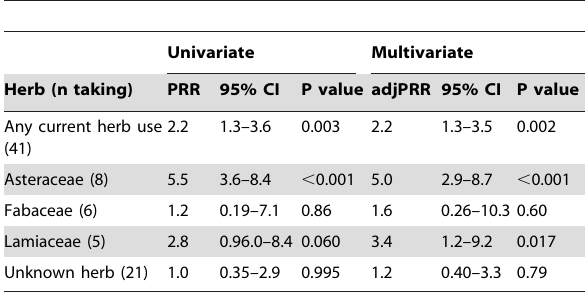
Multivariate model for all participants adjusts for: age, occupational fishing, HIV infection, positive Hepatitis B surface antigen, gender, heavy liquor use ( $ 1.25 L/week). Only participants with a valid TE scan (962/1000) were included in the model. CI (Confidence Interval).